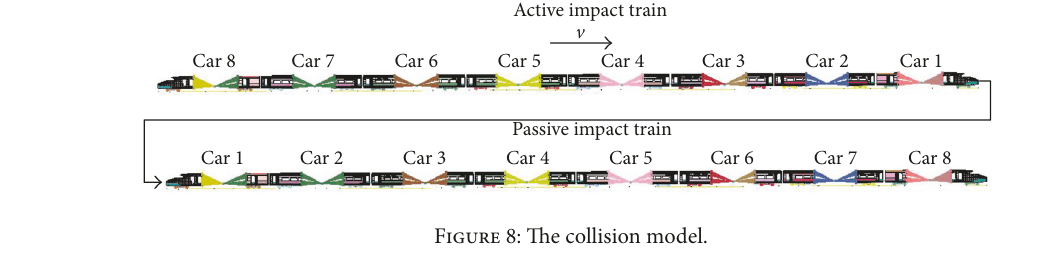
Figure 8: The collision model.